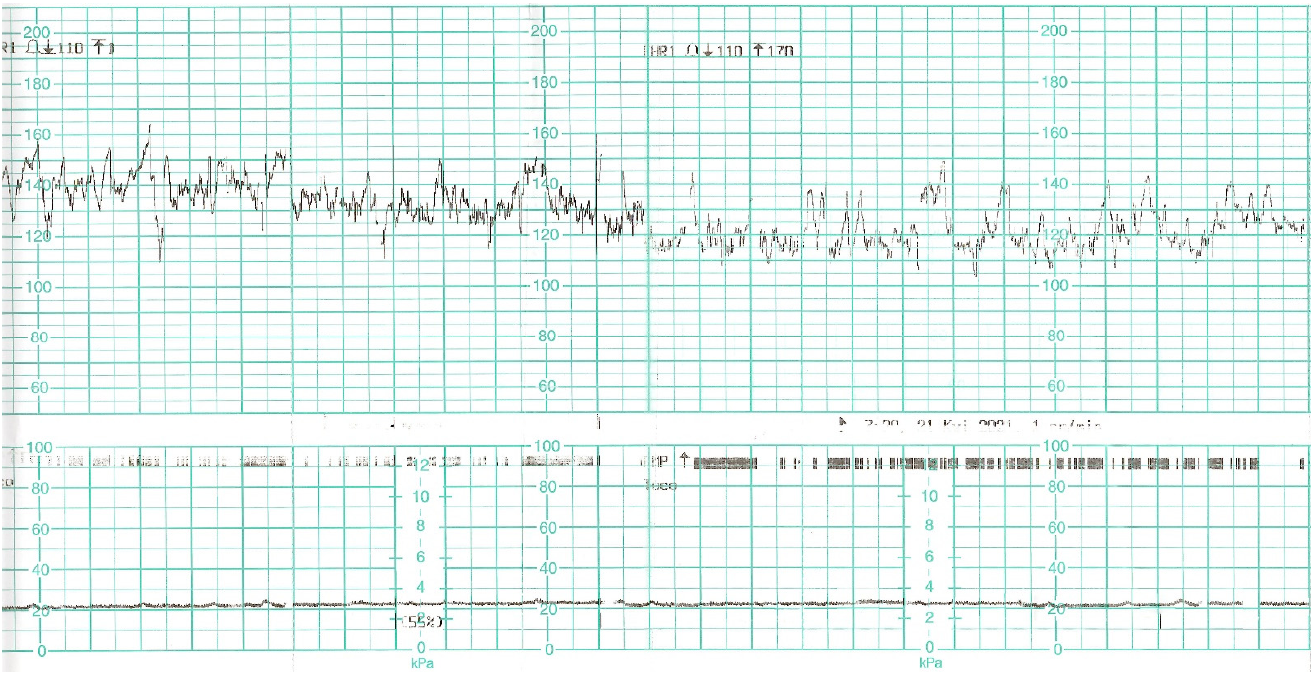
Figure 6. Cardiotocographic record made on day 0 of hospitalisation-normal baseline, normal vari-